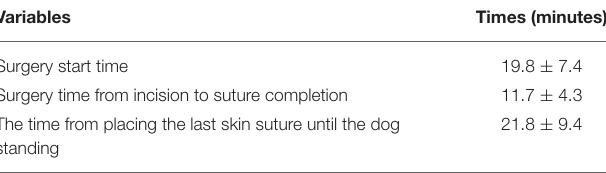
TABLE 3 | Time related with surgical procedures at Phase